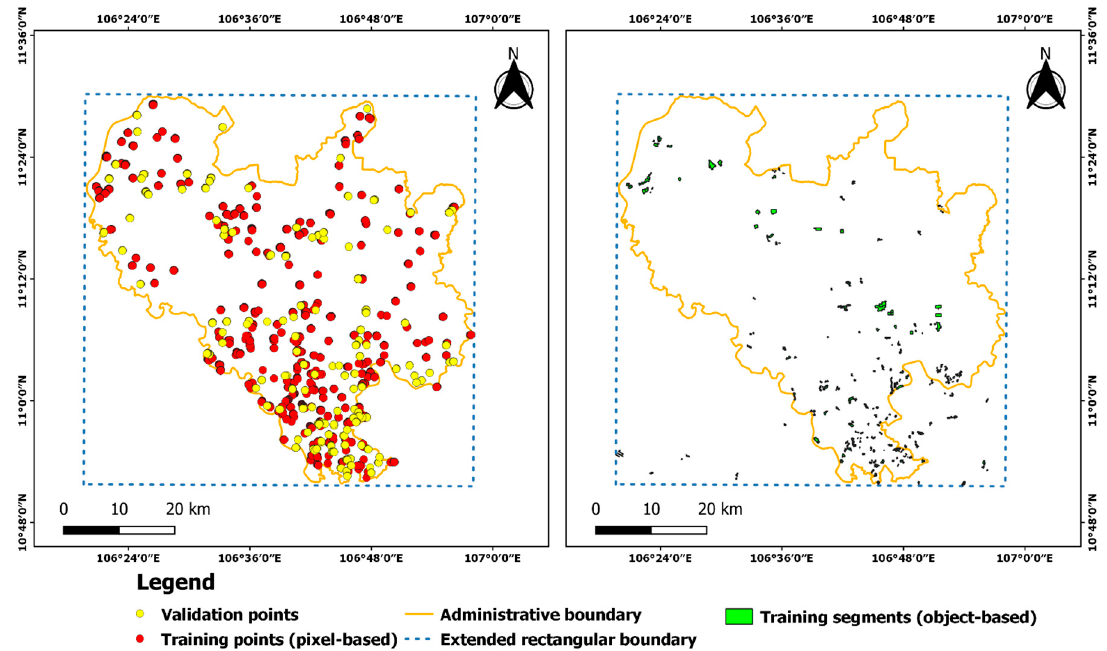
Figure 3. The spatial distribution of training and validation data.